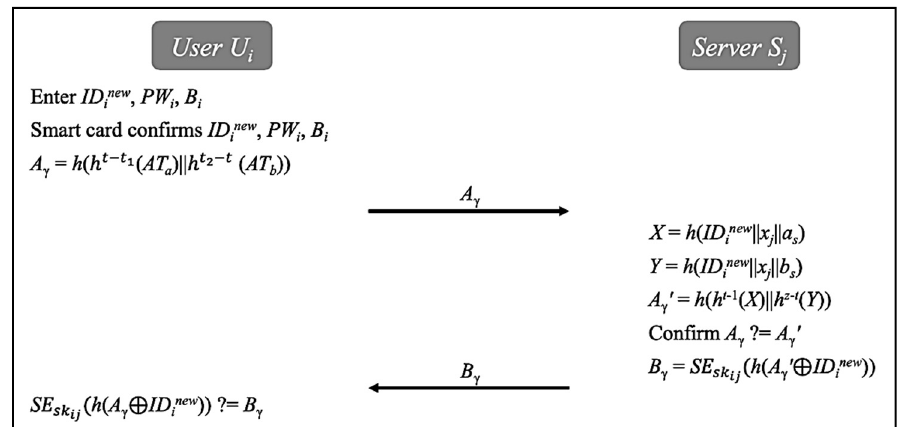
Figure 5. Fast authentication phase.